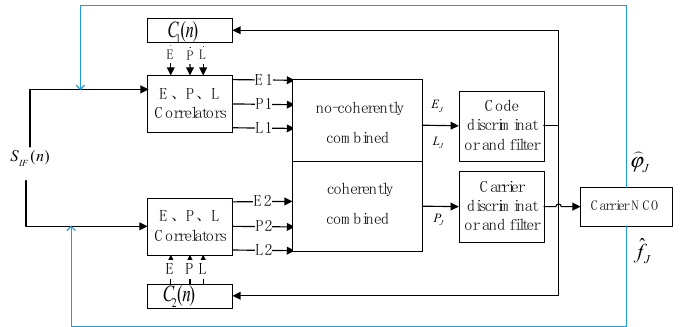
Figure 1. Framework of correlator joint receiving. The receiver correlator outputs early branch E and promotes branch P and later branch L. To fully use all the energies of the two components, a combination is performed after the correlator. Based on Table 2, the phase relationship between the signal compo- nents is syndromic for the L1C (GPS, QZS2–4) and E1OS signals. The phase relationship between the signal components was orthogonal for the B1C, L1C(QZS1), B2a, and B2 sig- nals. Consequently, the output of the correlator after joining can be expressed as 2 1